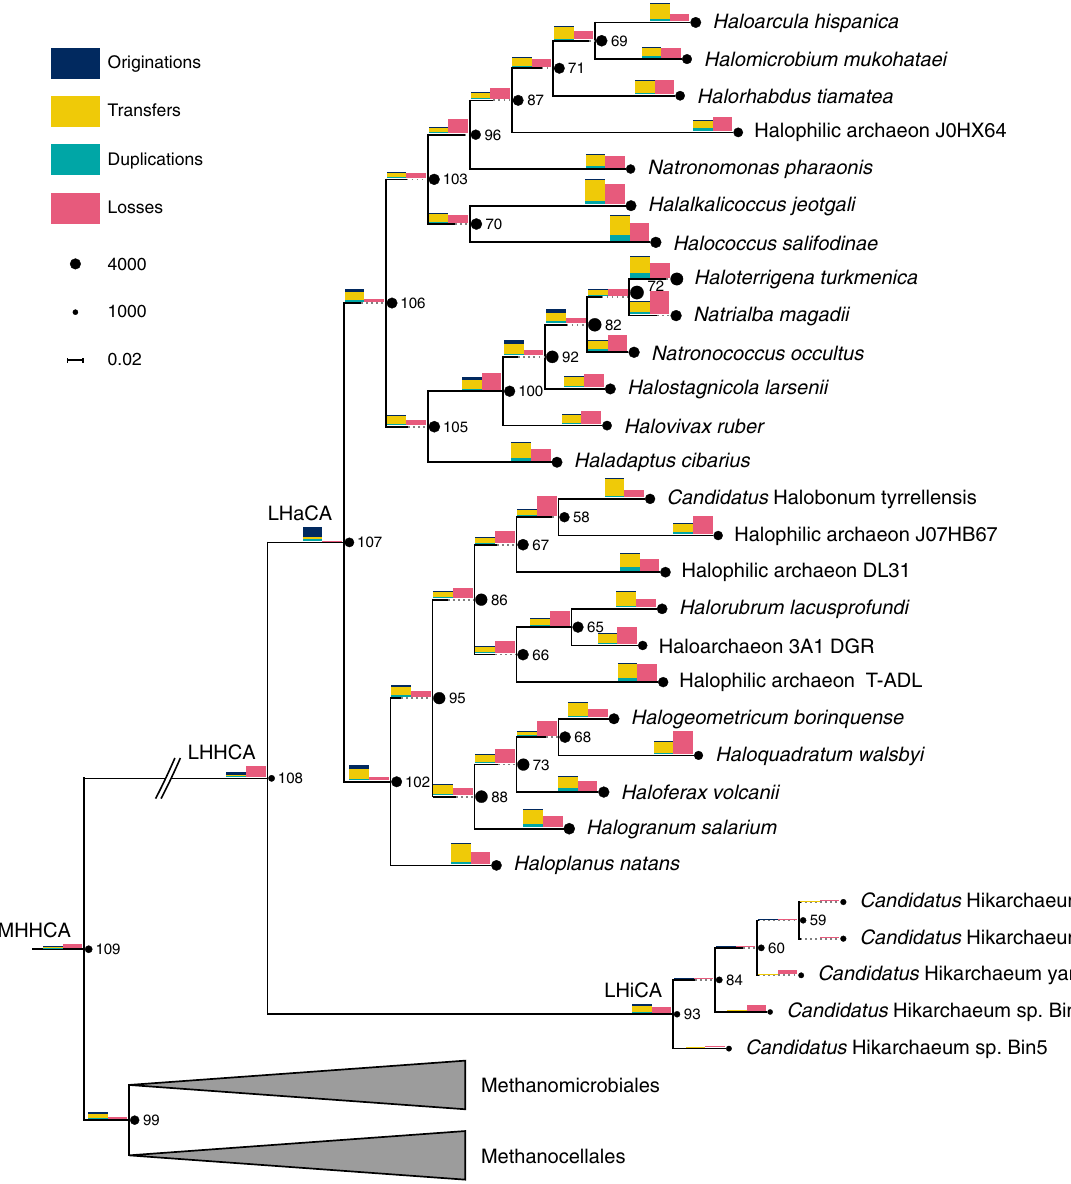
Fig. 3 Ancestral reconstruction tree. Phylogenetic tree corresponds to the Bayesian consensus tree reconstructed from the Methanotecta supermatrix alignment (30% most heterogeneous sites removed; Supplementary Fig. 22). Nodes are annotated with their (inferred) genome size represented by the area of the black circles, branches are annotated with bars representing the number of duplications, transfers and origination as well as the number of losses (bar heights in legend correspond to 2000 such events each). For internal nodes, the number code identifying the branch in the ALE analysis is given. Some branches were extended with dotted lines to fi t the width of the bars, and the branches leading to Methanomicrobiales and the ancestor of Haloarchaea and Hikarchaeia were collapsed for increased